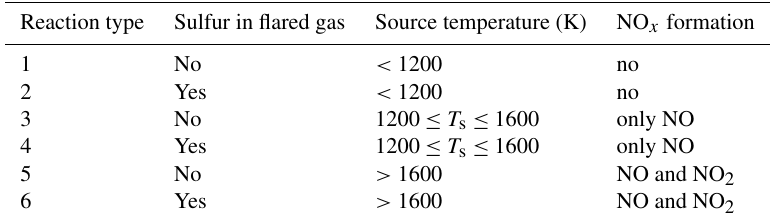
Table 1. Reaction types for incomplete combustion of flared gas, depending on availability of sulfur in the flared gas and the temperature in the combustion zone that determines the formation of NO and NO 2 .